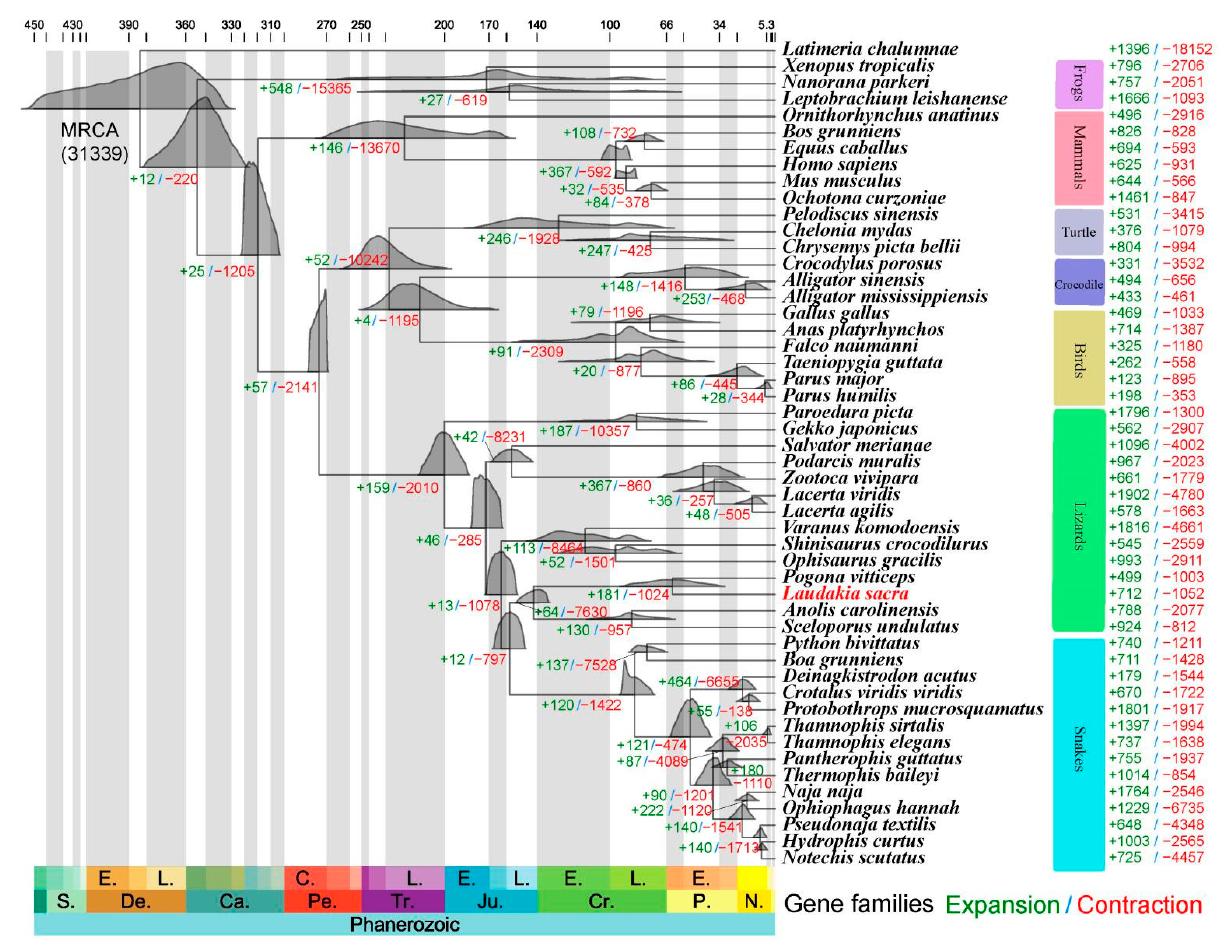
Figure 3. Reconstructed phylogeny of 50 species using single-copy orthologous groups identified in their genomes. Phylogenetic tree is scaled by divergence time, with geological times indicated below and divergence times in Mya provided above. Laudakia sacra whose genome is sequenced in this study is highlighted in red. Green and red numbers indicate number of significantly expanded (+) and contracted ( − ) gene families, respectively. E., early; L., late; C., Cisuralian; S., Silurian; De., Devonian; Ca., Carboniferous; Pe., Permian; Tr., Triassic; Ju., Jurassic; Cr., Cretaceous; P., Paleogene; N,. Neogene.